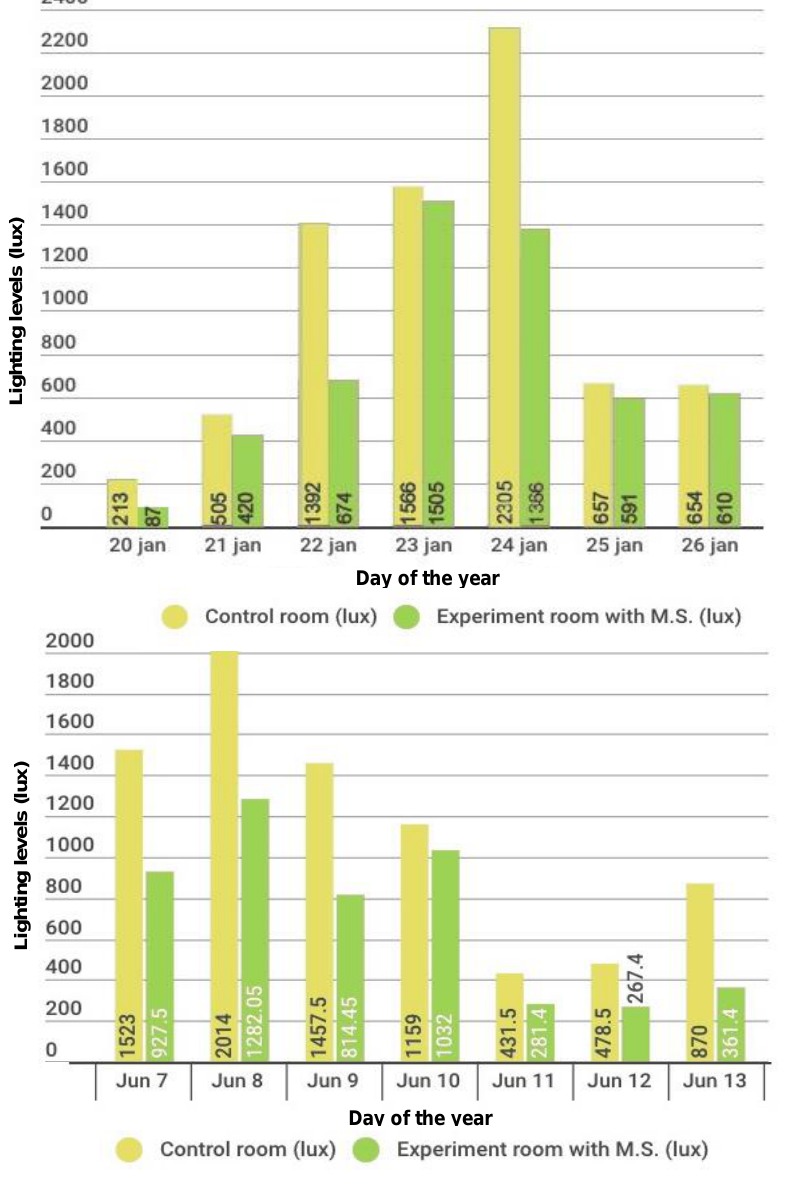
Figure 10. The figure represents the lighting outcomes in both the control room and experiment rooms in both the warmest and coolest times of the